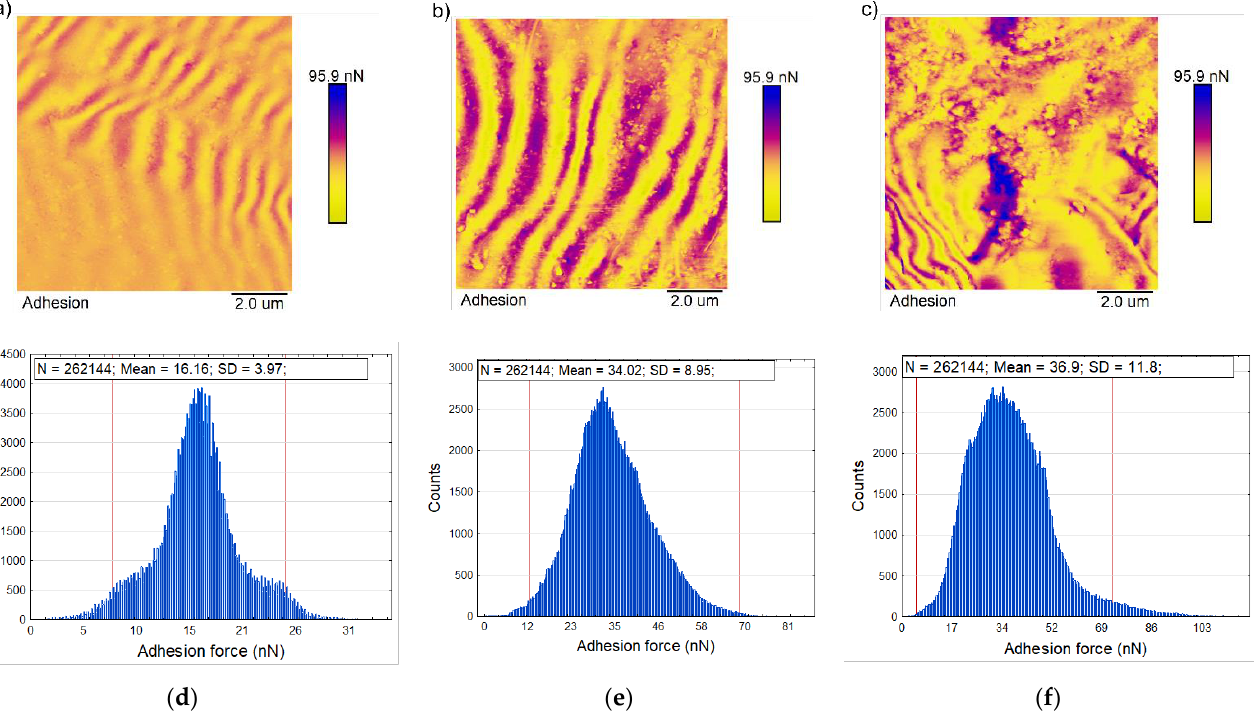
Figure 6. Representative map of the adhesion forces (10 × 10 μm) for samples k0 ( a ), k5 ( b ), k10 ( c ), and the corresponding histogram ( d – f ) of the distribution of the adhesion forces. The red line superimposed on the frequency histograms represents the 95% range of the measured values.